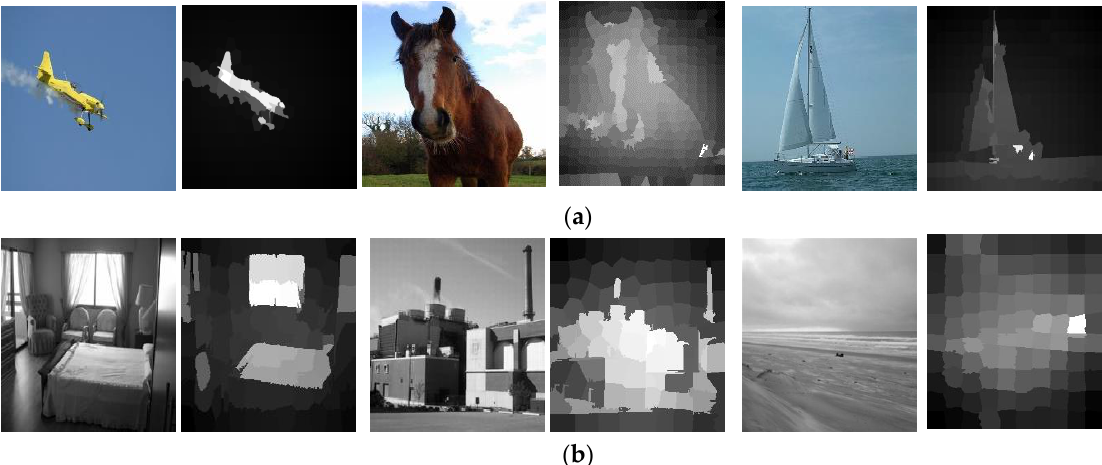
Figure 6. Saliency maps for the images from VOC 2007 and 15-Scene. ( a ) Saliency maps for images taken from Pascal VOC 2007; ( b ) Saliency maps for images taken from 15-Scene.